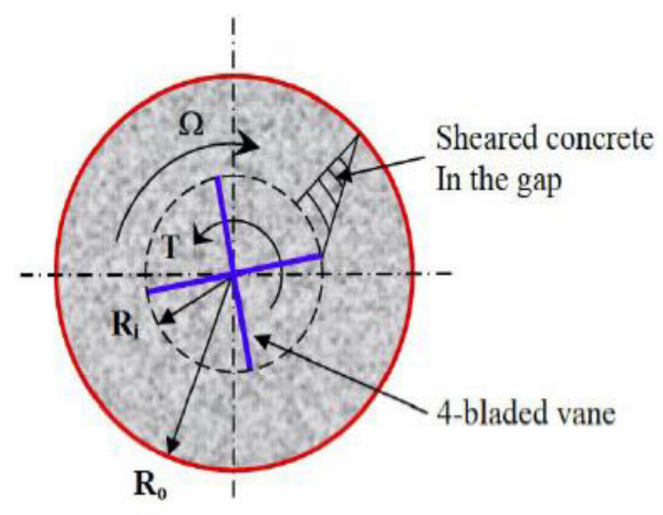
Figure 4. Test principle of ICAR rheometer